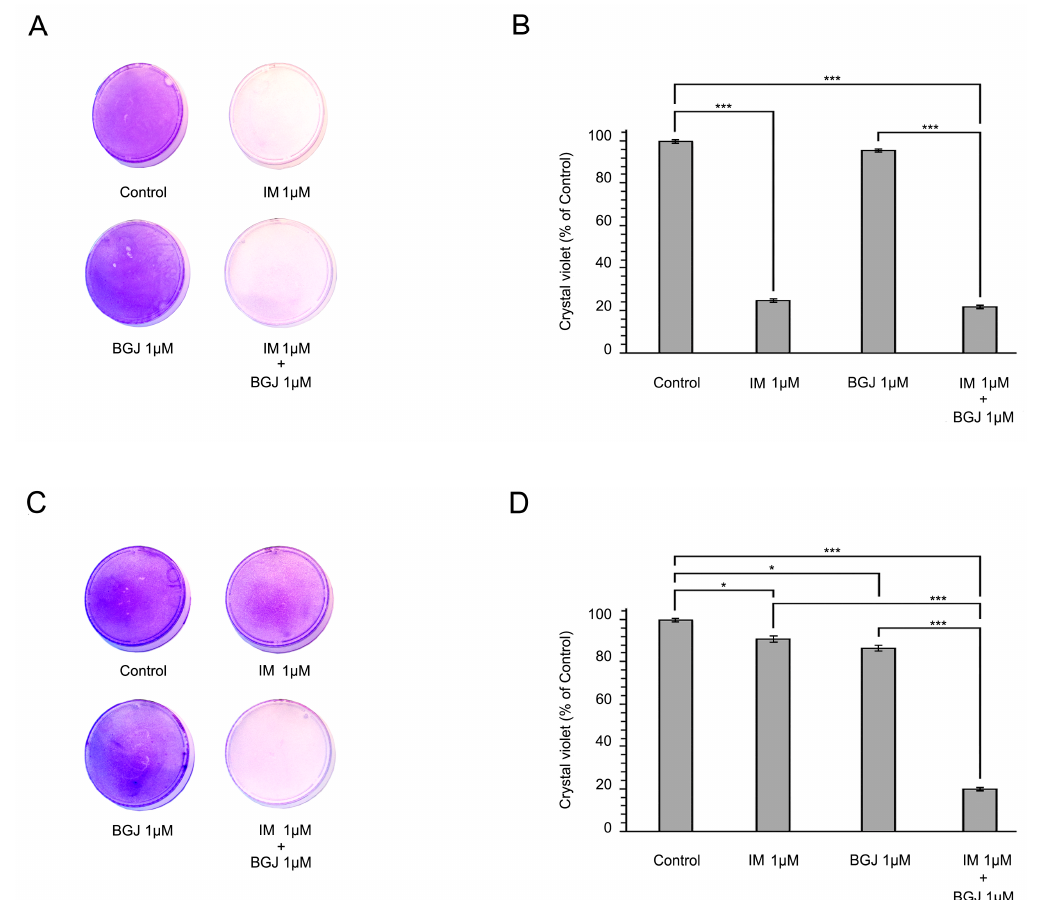
Figure 2. Inhibition of fibroblast growth factor receptor (FGFR) signaling sensitizes IM-resistant GIST cells to IM. Crystal violet staining of GIST T-1 ( A ) and GIST T-1R ( C ) cells. Cells were treated with DMSO (control), BGJ398 (1 µ mol/L), or IM (1 µ mol/L) alone or in combination for 6 days. The culture dishes were fixed, stained with crystal violet, and photographed. ( B , D ) Quantitative analysis of crystal violet staining of IM-sensitive ( B ) and IM-resistant GIST cells ( D ). The plates were dried, crystal violet was dissolved using 0.1% SDS solution, and absorbance was measured at 590 nm. The graphs represent the mean ± SD. * p < 0.05; *** p <